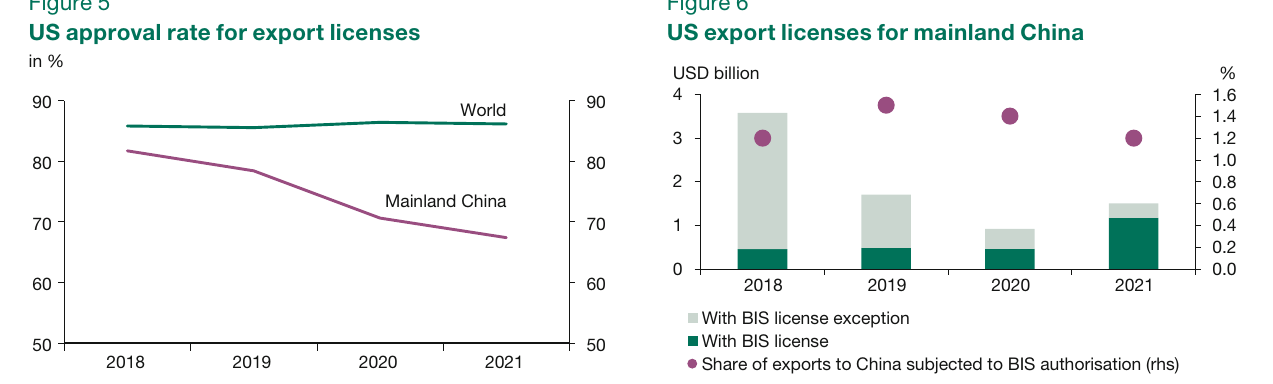
Sources: Natixis, US Department of Commerce’s Bureau of Industry and